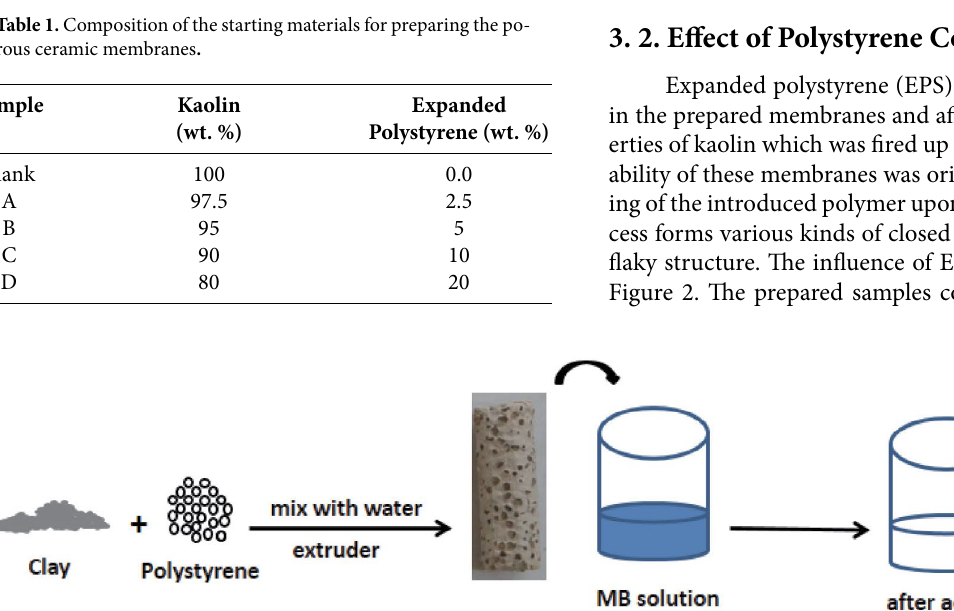
Figure 1. Schematic illustration for the ceramic membrane preparation and using it in adsorbing methylene Table 2. Chemical composition of Kaolin . Kaolin components